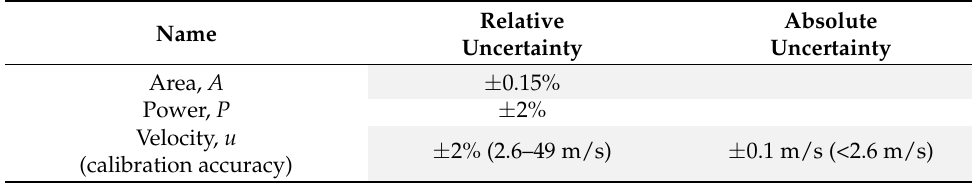
Figure 1. The model of SJA ( a ), and the test stand with the actuator 1B ( b ). Table 2. Uncertainty of